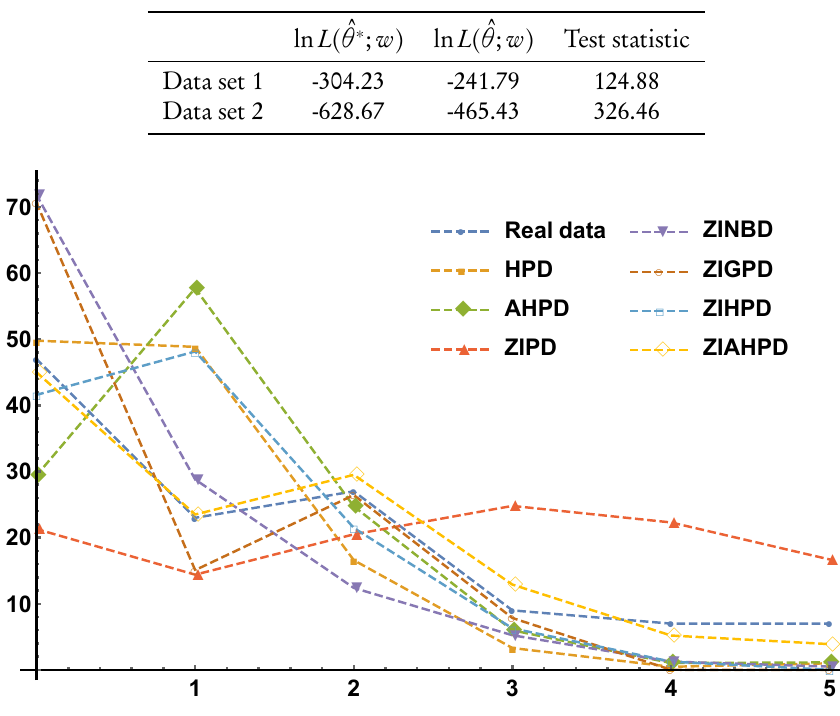
Calculated value of the test statistic in case of the generalised likelihood ratio test.